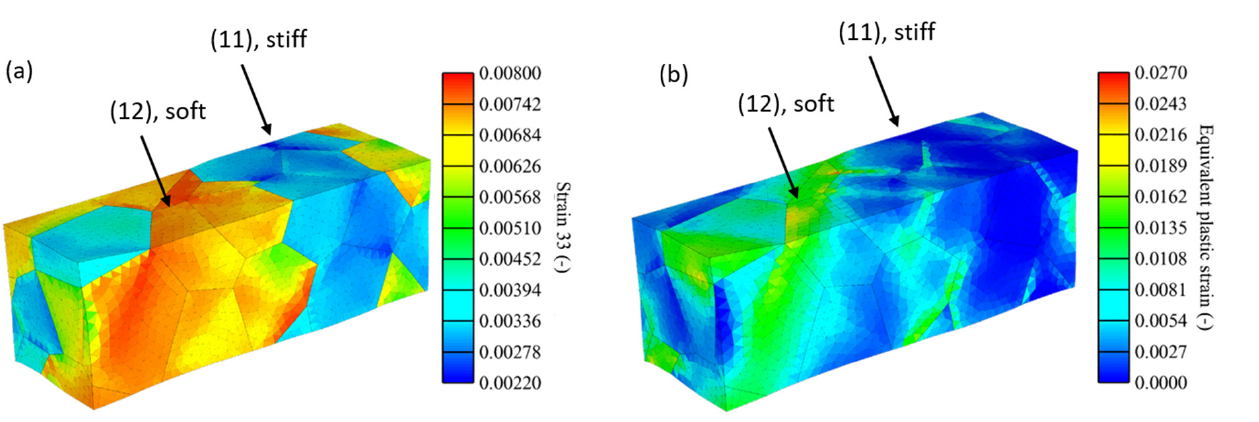
Figure 9. Elastic strain S33 in loading direction ( a ) and equivalent plastic strain ( b ) for the mix ori- entated specimen.